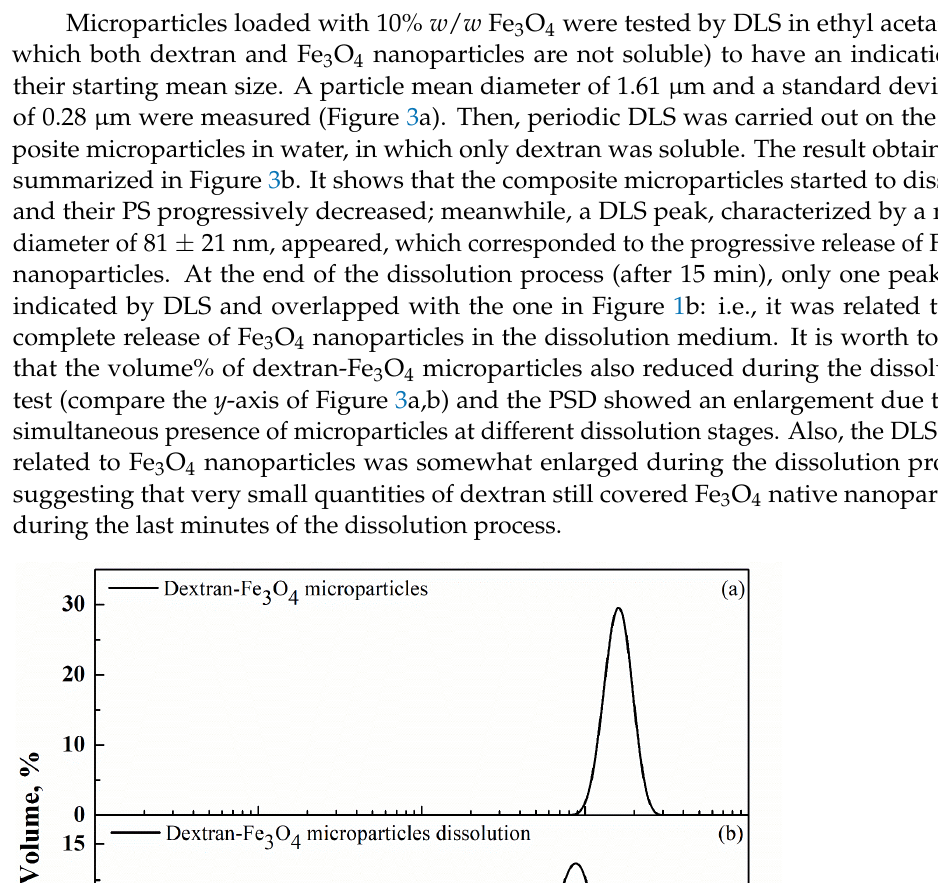
Figure 2. SEM image of dextran microparticles loaded with 10% w / w Fe 3 O 4 nanoparticles, produced by SAA in this work.